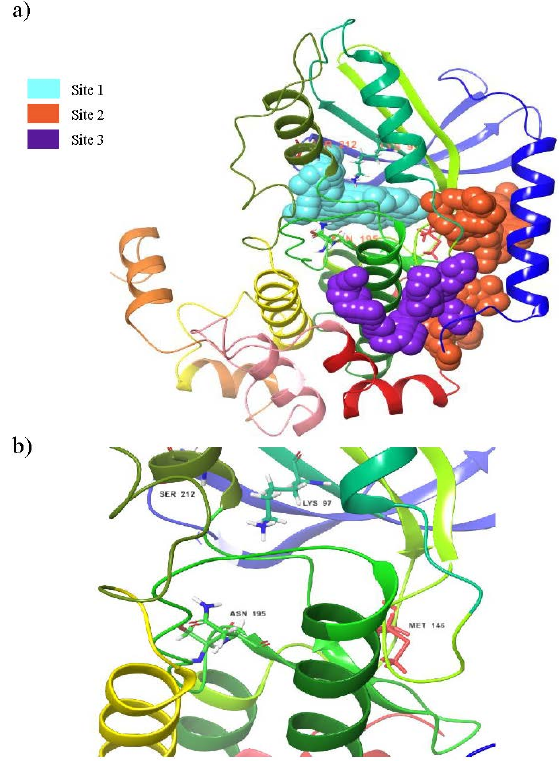
Figure 1. ( a ) Schematic representation of top three predicted binding sites. ( b ) Functionally important residues in site 1.